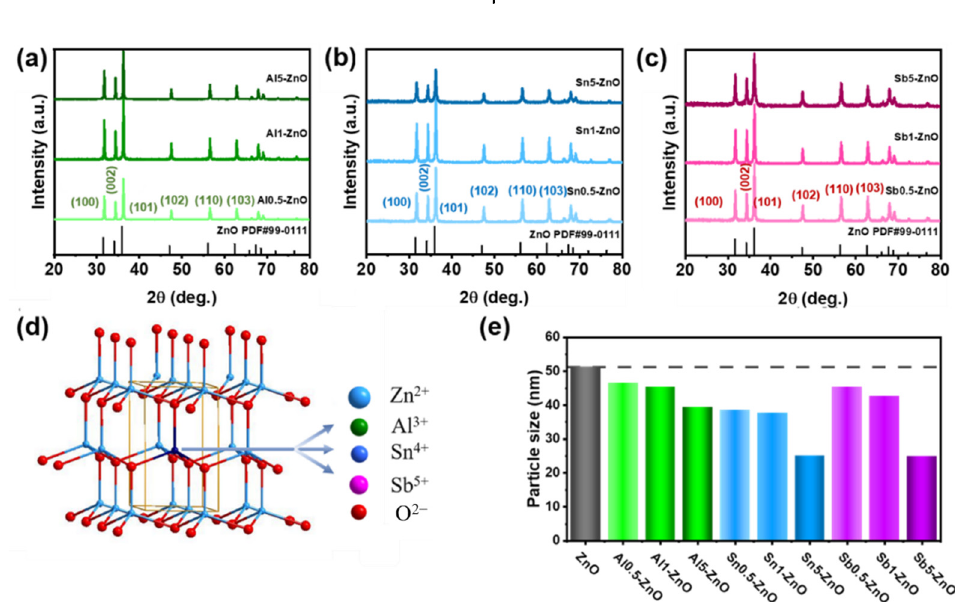
Figure 1. ( a – c ) XRD patterns of various samples. ( d ) The ball and stick model of ZnO crystal structure for which the Zn 2+ is replaced by Al 3+ , Sn 4+ , or Sb 5+ . ( e ) Average crystallite size of ZnO and various dopants doped ZnO.